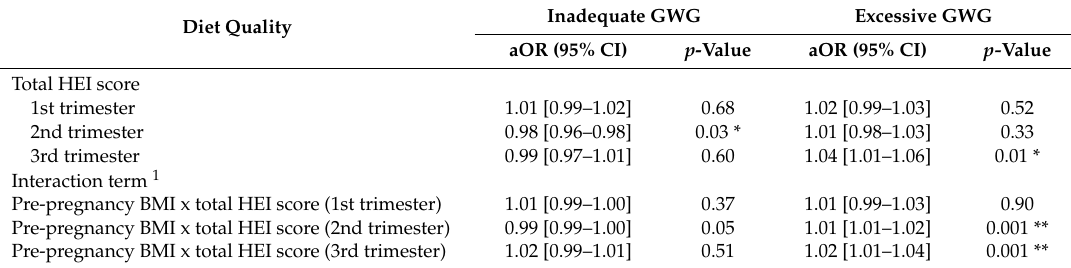
Table 4. Adjusted OR for associations between total HEI score in each trimester and GWG. Diet